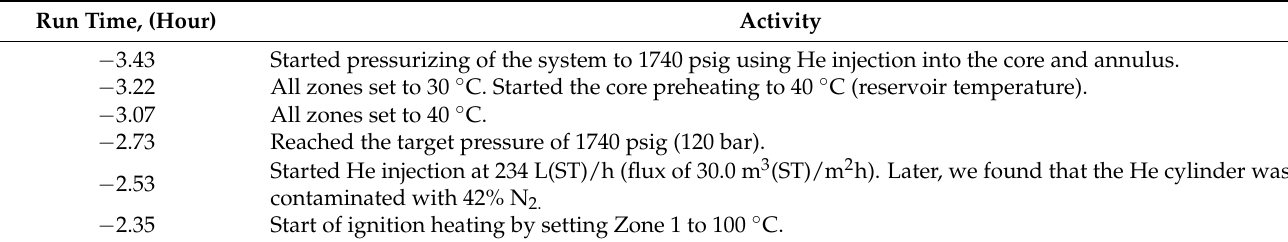
Table 4. Main events of the vuggy CT